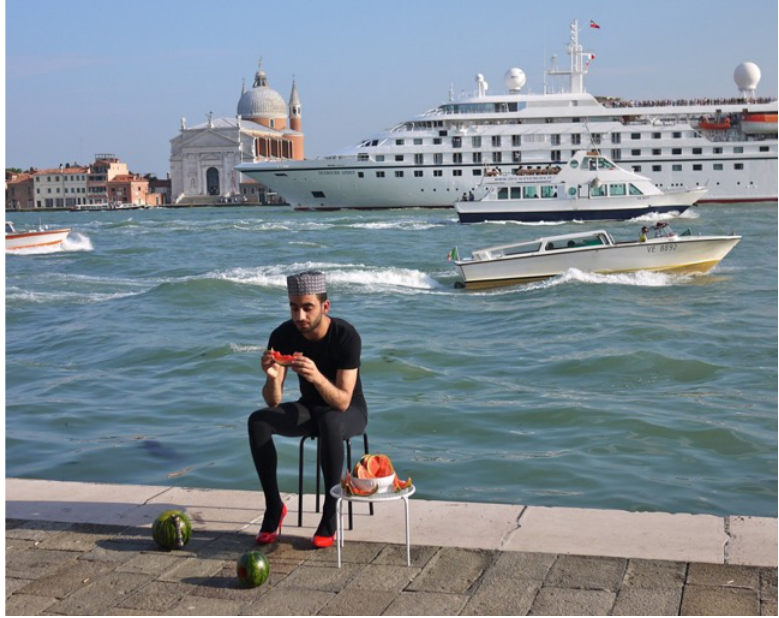
Mehdi-Georges Lahlou, Stupidité contrôlée ou Autoportrait à la Pastèque (detail), 2011. Performance. Zattere, Venice. Courtesy of the artist and Galerie Transit, Mechelen, Belgium. (photo: Bert de